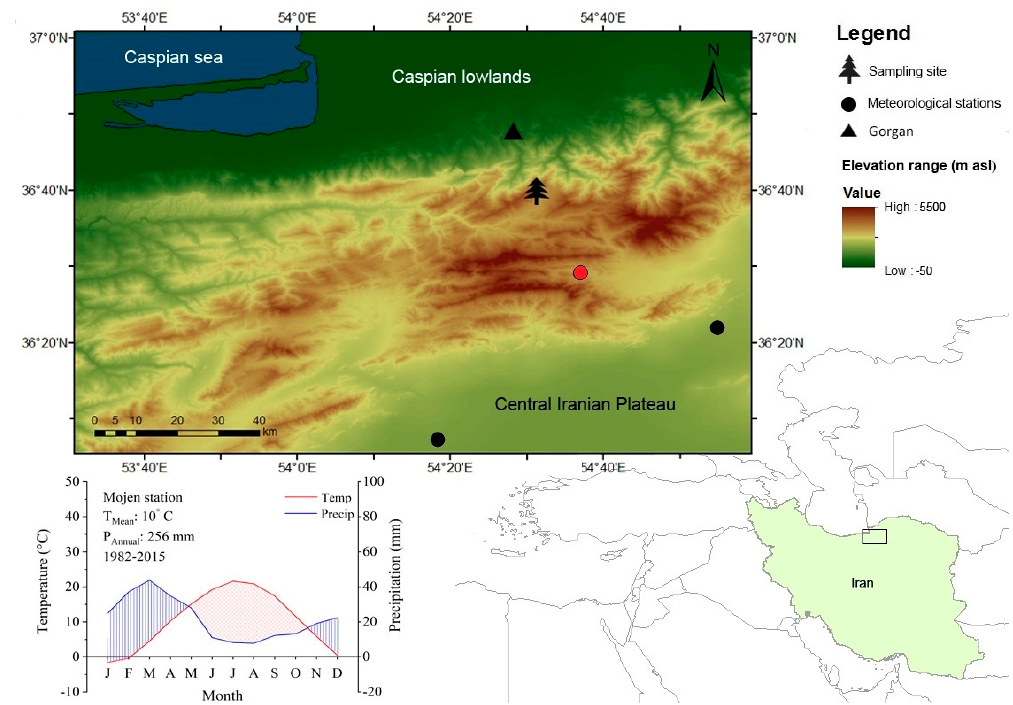
Figure 1. Location of Iran and the study area (rectangle in overview map). Tree symbol: sampling site, Triangle: Gorgan provincial capital, Circle: meteorological stations, Mojen meteorological station marked with red circle. Inlay: climate diagram of Mojen meteorological station (1982–2015).